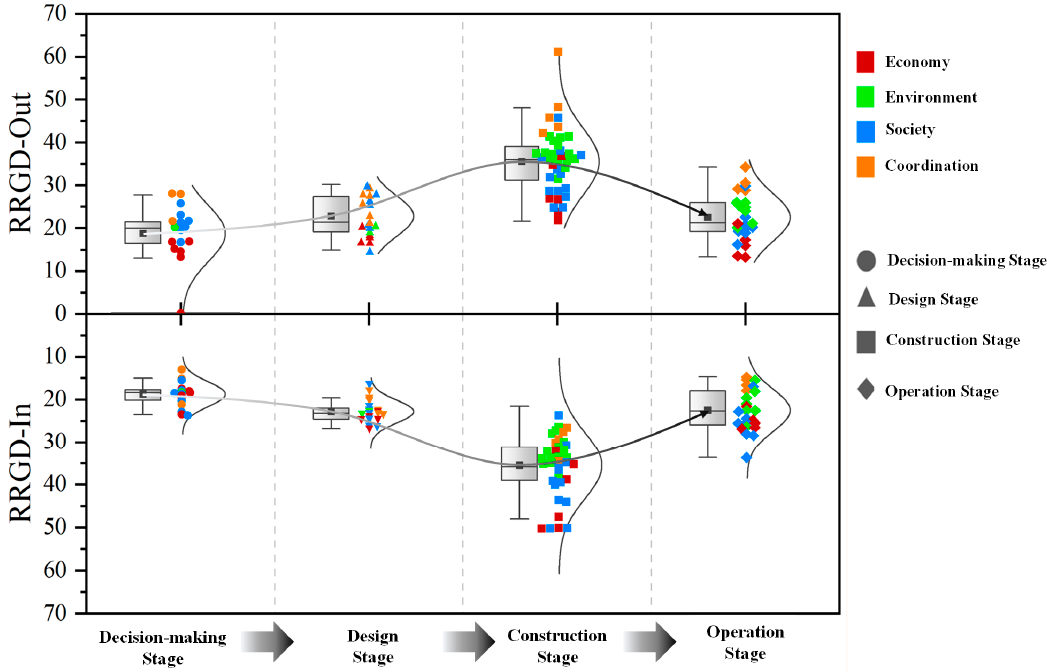
Figure 4. The evolution of RRGD ‐ Out and RRGD ‐ In.